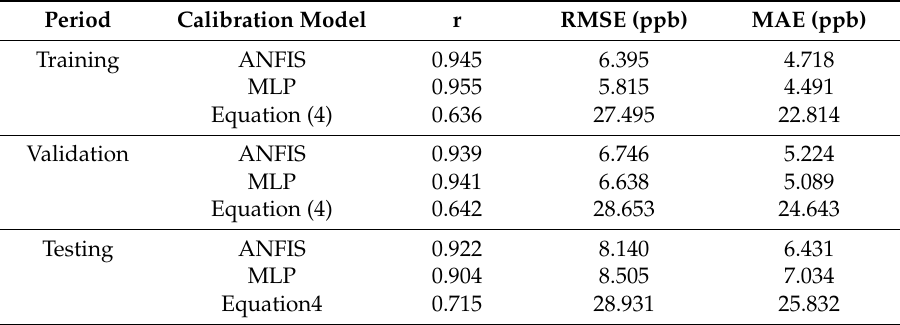
Figure 14. The relationship between O 3 values measured with the reference instrument and the three calibration models ANFIS, ANN (MLP) and Equation (3) during the testing period. Table 6. Different errors in translating signal to mixing ratios of O 3 using the calibration models which were developed using ANFIS, MLP and Equation (3) as compared with the mixing ratio of O 3 obtained from the reference instrument during the training, validation, and testing period.